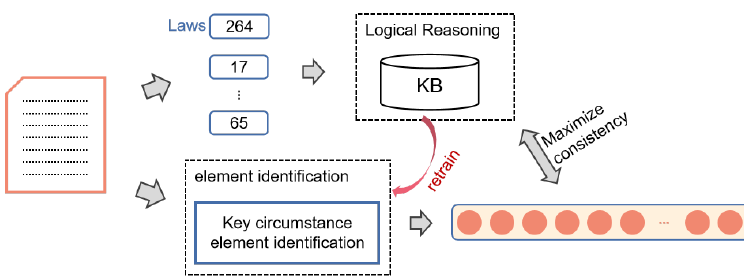
Figure 3. The architecture of key circumstance element